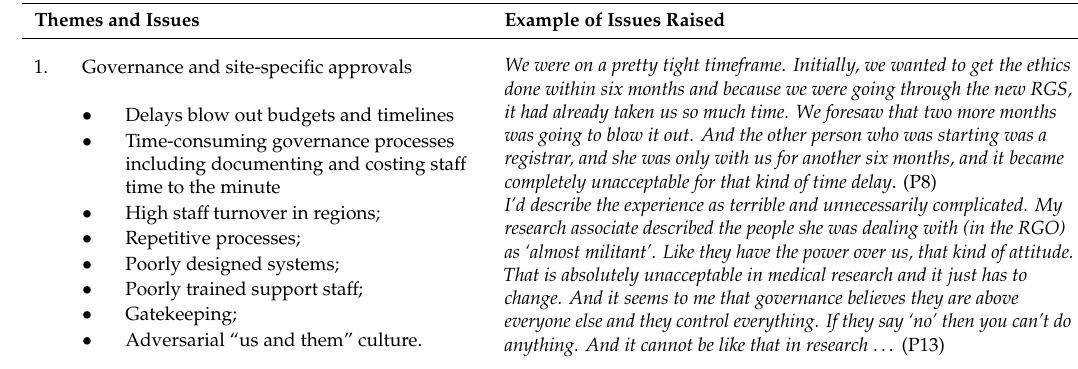
Table 1. Reported additional challenges for rural